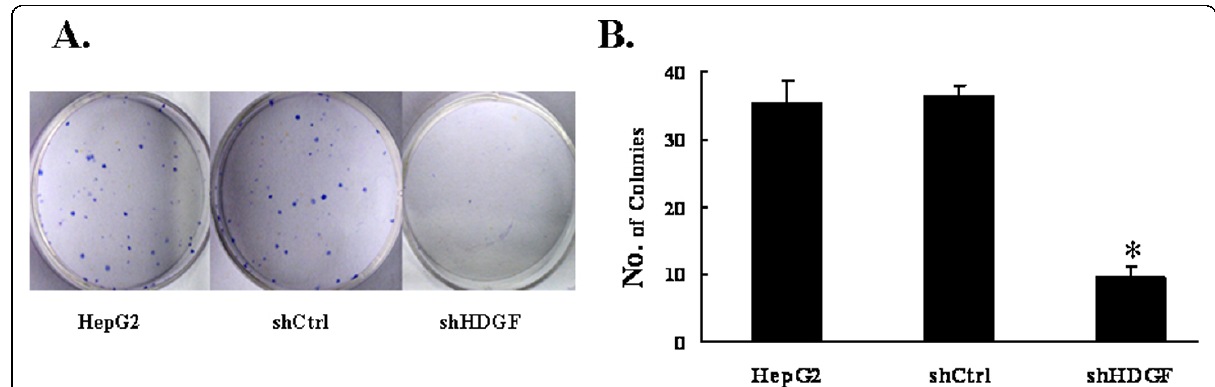
Figure 4 Down-regulation of HDGF inhibited cell transformation . The anchorage-independent growth of parental HepG2 cells and their stable derivatives, shCtrl and shHDGF, were examined by soft agar colony formation assay. A . Colonies were photographed. B. Bar graph showed the differences of colony formation among the three groups. Data were presented as mean ± SD for three independent experiments. * P < 0.05, as compared to parental HepG2 cells and shCtrl